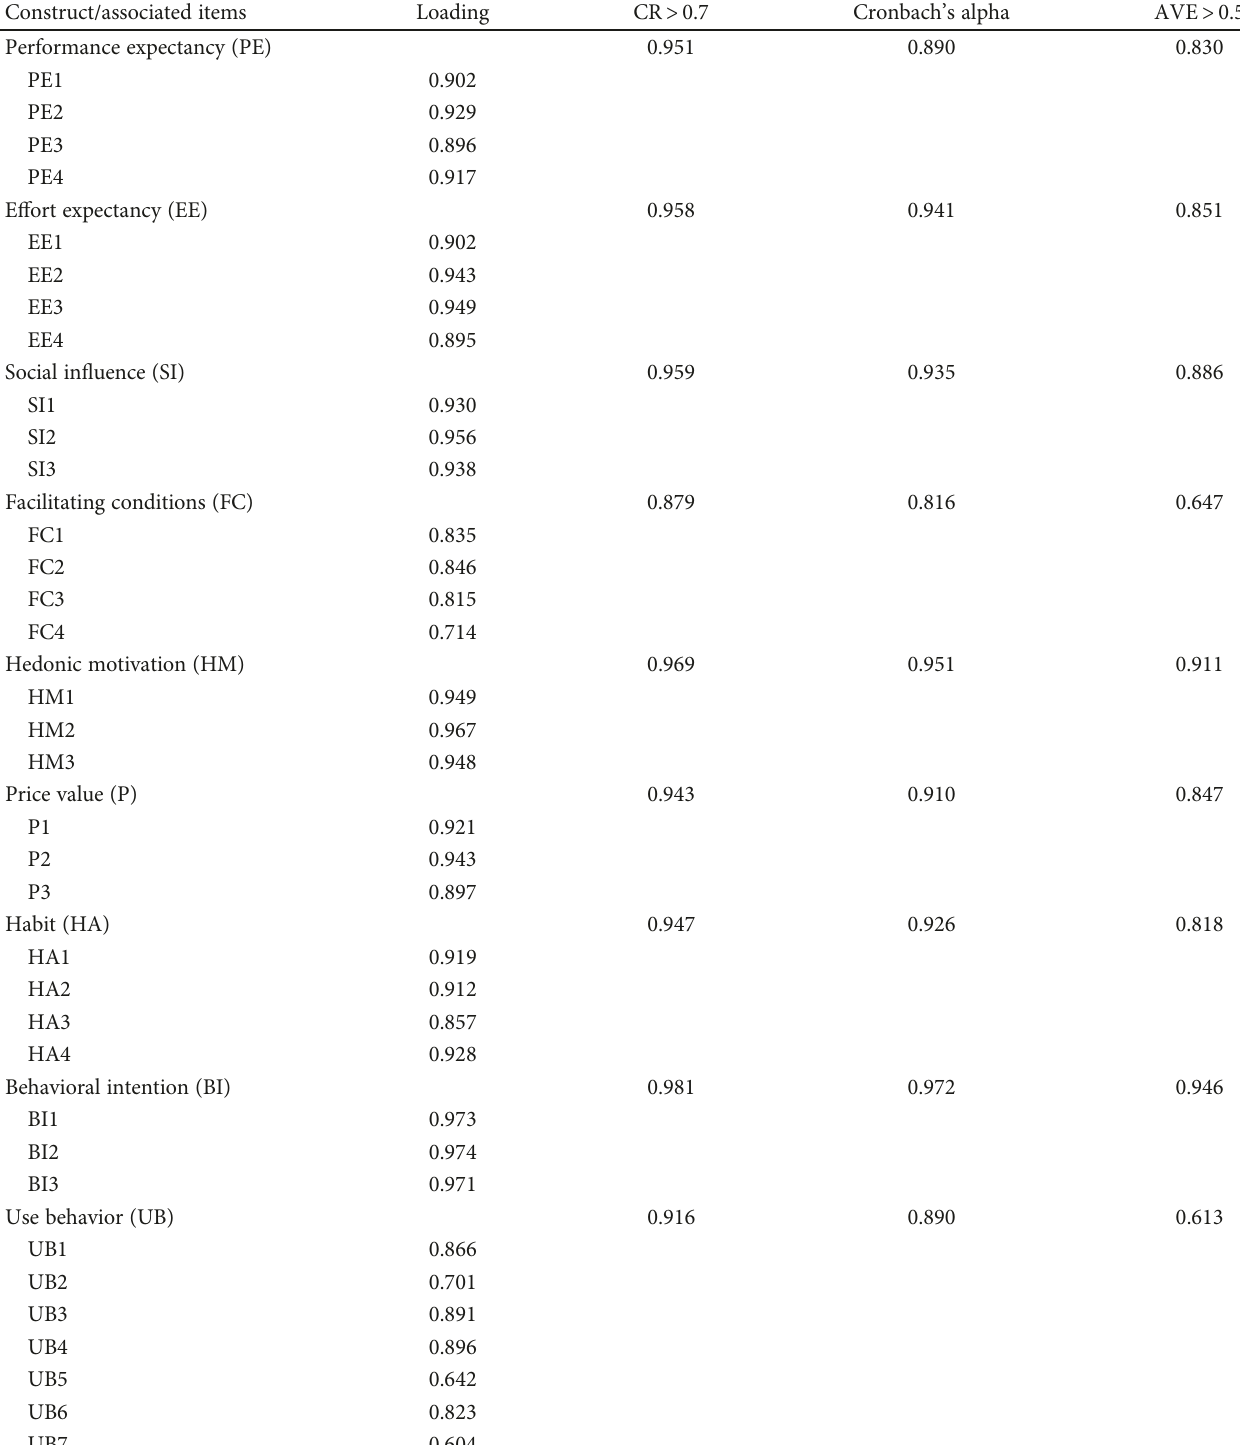
Table 2: Assessment results of the measurement